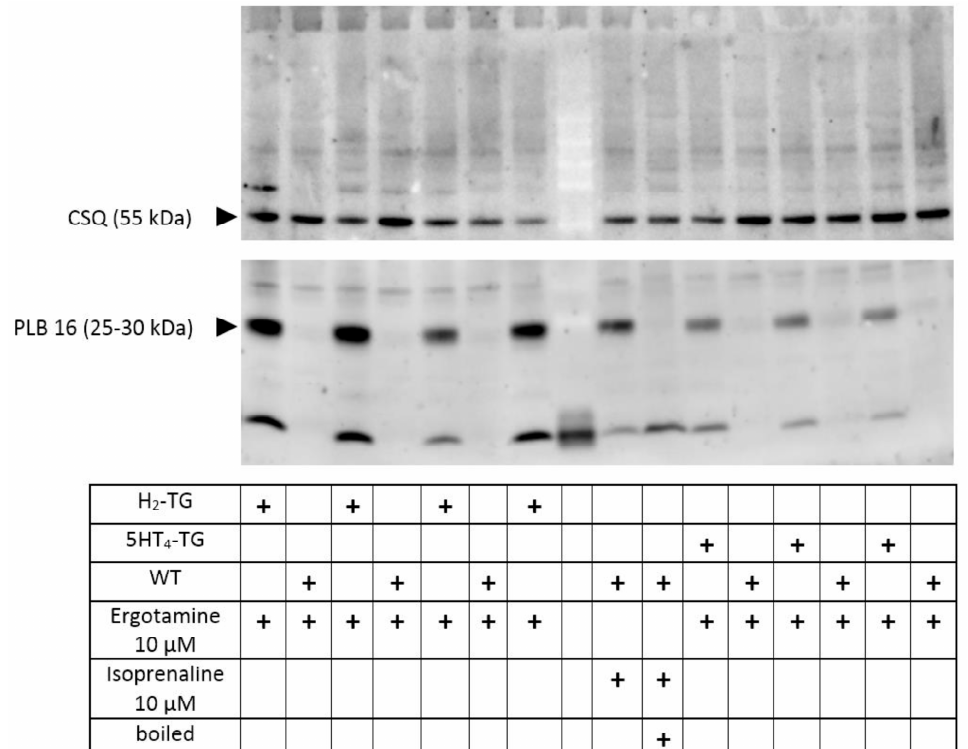
Figure 6. Ergotamine increases the phosphorylation state of phospholamban: contracting prepara- tions as seen in Figures 2 and 4 were freeze-clamped after the addition of ergotamine 10 µM (see fourth row in the table below the Western blot). This was done with left atrial preparations from wild type mice (WT) as negative control, and also in atrial preparations from 5-HT 4 -TG or H 2 -TG as indicated by “+”. No additional histamine or serotonin was added. Typical Western blots are seen. Western blots depict serine 16 phosphorylated phospholamban (PLB) with arrows. As a loading control, we assessed the protein expression of calsequestrin (CSQ) by cutting the lanes of the blot horizontally and incubating the lower and upper halves with different primary antibodies. Relevant molecular weight markers are indicated with arrows and marked with kilodalton (kDa). As a positive control, samples from atrium treated with 10 µ M isoprenaline are shown in the middle. Boiled means that the isoprenaline-treated atrium was brought to the temperature of 95 ◦ C for 10 min and was then rapidly loaded on this original gel. Please note the mobility shift in the boiled sample confirming that we really detected phospholamban. In the middle row (empty), we allowed the molecular weight marker to run.